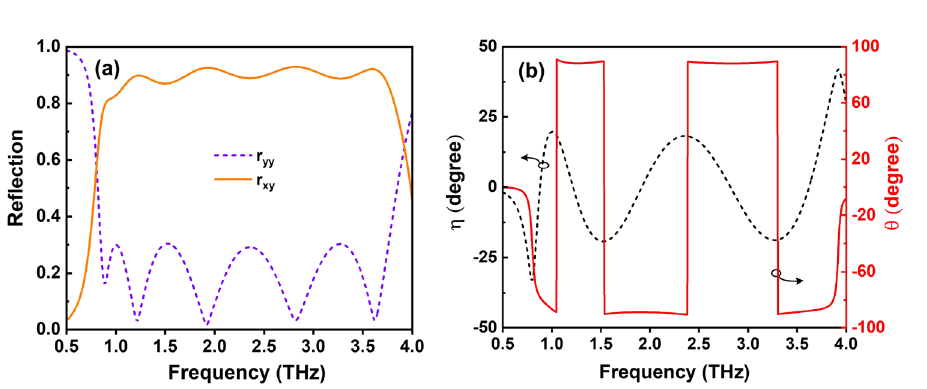
Figure 11. ( a ) The simulated magnitude of reflection coefficients and ( b ) the calculated ellipticity angle ( η ) and polarization azimuth angle ( θ ) of the proposed RMS for PC